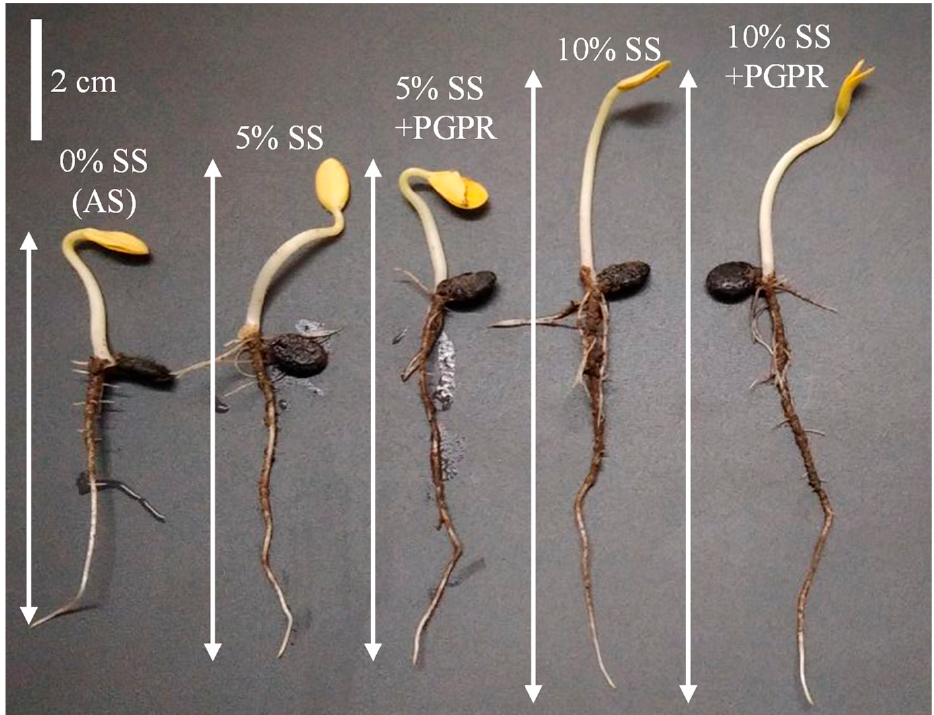
Figure 3. Effect of sewage sludge (SS) and plant growth-promoting rhizobia (PGPR) amendment on seedling growth of Ridge gourd ( L. acutangula ).